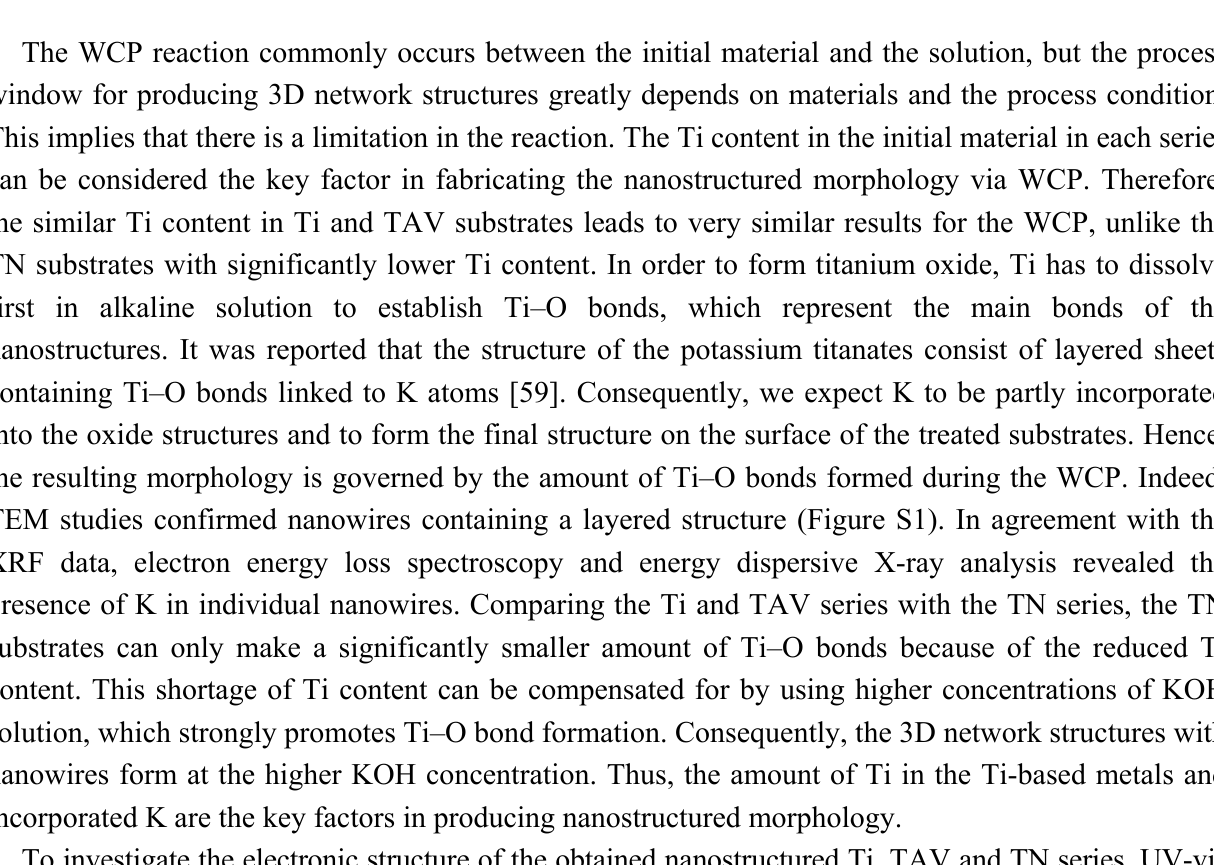
Figure 5. Content of potassium in obtained nanostructured oxide films from X-ray fluorescence (XRF). The general trend for content of potassium in nanostructures is remarkably similar with Ti and TAV series. However, the overall tendency of the K content in the TN series is shifted toward higher KOH concentration regions. The value of 10 mol/L-KOH-treated TN was below the limit of the measurement and therefore not visible, and cannot be seen in the figure. The shortage of Ti content can be compensated for by using higher concentrations of KOH solution, which promotes nanowires